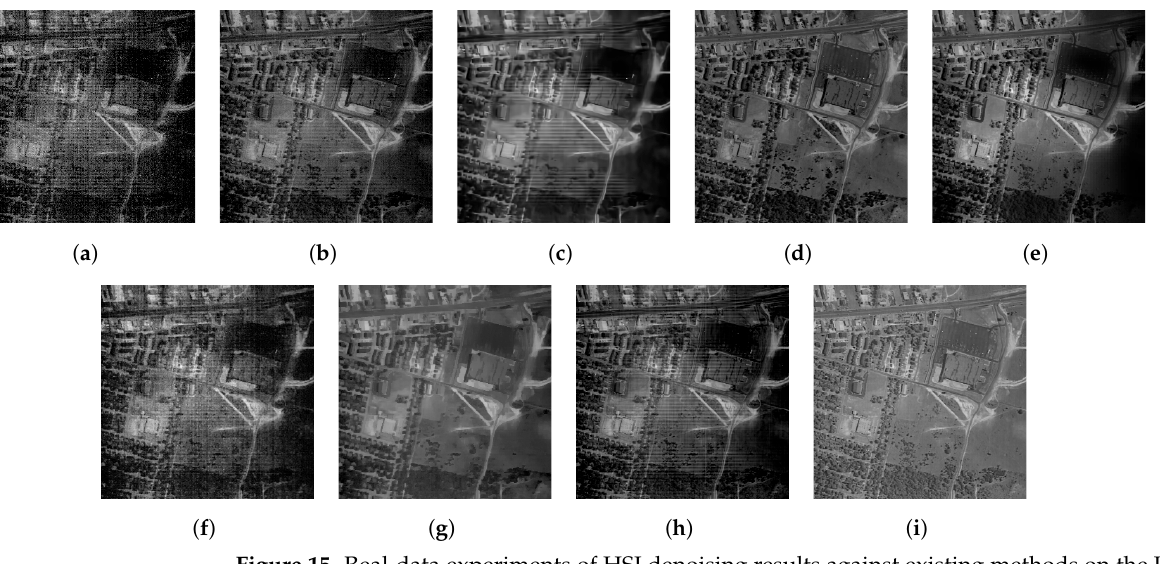
Figure 15. Real-data experiments of HSI denoising results against existing methods on the Urban dataset: ( a ) original image of band 108; ( b ) NNM; ( c ) BM4D; ( d ) WNNM; ( e ) WSNM; ( f ) LRTDTV; ( g ) 3DTV; ( h ) FastHyDe; and ( i ) the proposed